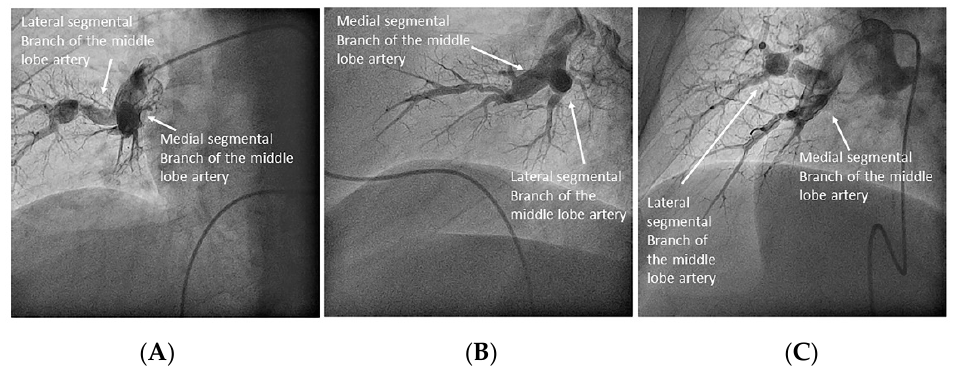
Figure 20. Segmental middle lobe artery branches (A4 and A5): ( A , B ) anteroposterior and lateral views overlapping; ( C ) cranial left oblique separates branches.